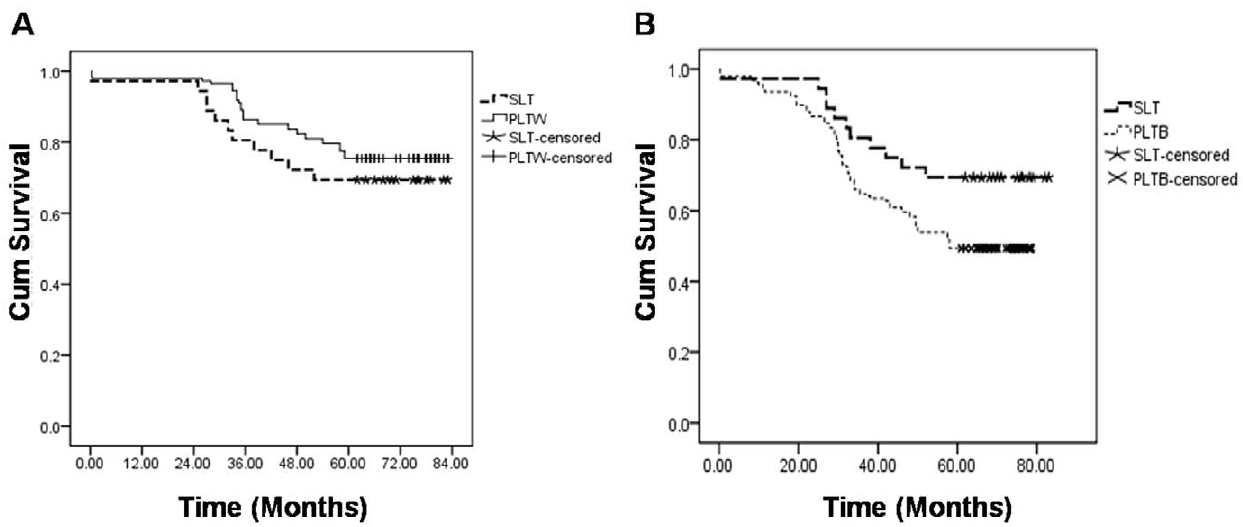
Figure 1. (A) shows the cumulative survival rate between SLT group and PLTW group, a Log-Rank test showed P =0.336. (B) shows the cumulative survival rate between SLT group and PLTB group, a Log-Rank test showed P =0.041. Abbreviation: SLT salvage liver transplantation, PLTW primary liver transplantation within Milan criteria, PLTB primary liver transplantation beyond Milan criteria. doi:10.1371/journal.pone.0041820.g001 PLoS ONE |